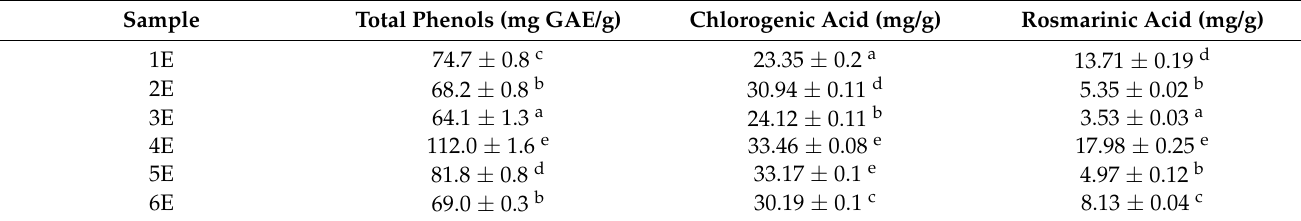
Table 4. Content of total phenols, chlorogenic acid and rosmarinic acid in methanolic extracts of Hyssopus officinalis subsp. aristatus . Different letters in the superscript indicate statistically different values at p < 0.05.